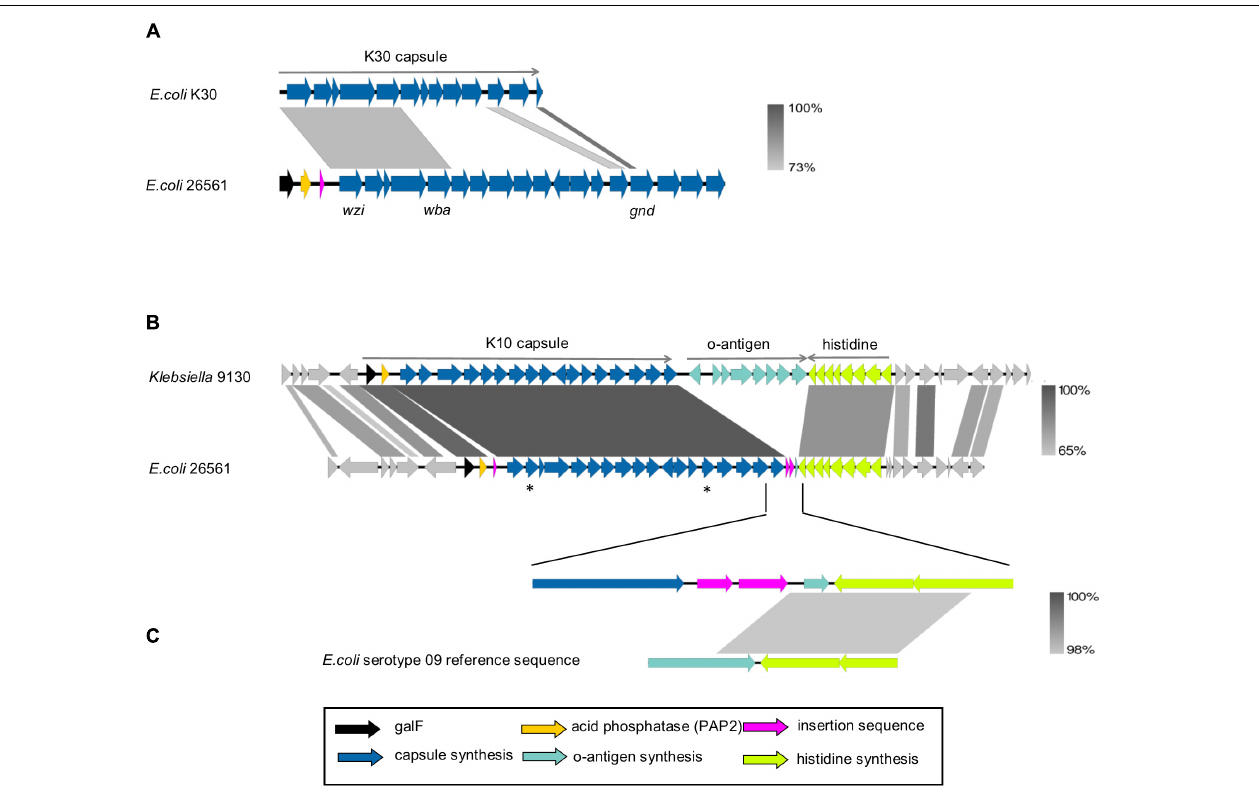
FIGURE 3 | Alignment of group 1 capsule loci. (A) Prototypical E. coli group 1 capsule locus (ec_K30) aligned to capsule locus of strain 26561. The reference sequence for E. coli K30 capsule (accession AF104912.3) spans 16,109 nucleotides comprising genes from wzi to the 5 (cid:48) end of gnd . The alignment shown corresponds to nucleotide identity of 73% between the first five genes; wzi-wza-wzb-wzc-wbaP , which are common to group 1 capsules. (B) Klebsiella NCTC 9130 is the reference strain for the Klebsiella K10 serotype. Shown is its nucleotide alignment to E. coli 26561 by BLAST with percent identities of the alignments represented by the gradient shown on the right. The central region of the capsule locus is the most strongly conserved, with genes between wza and wbaZ (marked by asterisks in the diagram) each sharing 99–100% identity. In 26561, an insertion sequence is present upstream of the first structural gene of the capsule, wzi, and two are found after the last gene in the locus , ugd . (C) The upper row is a close-up of 26561, where the insertion sequences are present following ugd . A small coding sequence of 54 amino acids is present downstream of the insertion sequences and upstream of the his operon. This is found to match 100% to the final 162 nucleotides of the E. coli O8 and O9 serotype reference sequences (bottom row; only O9